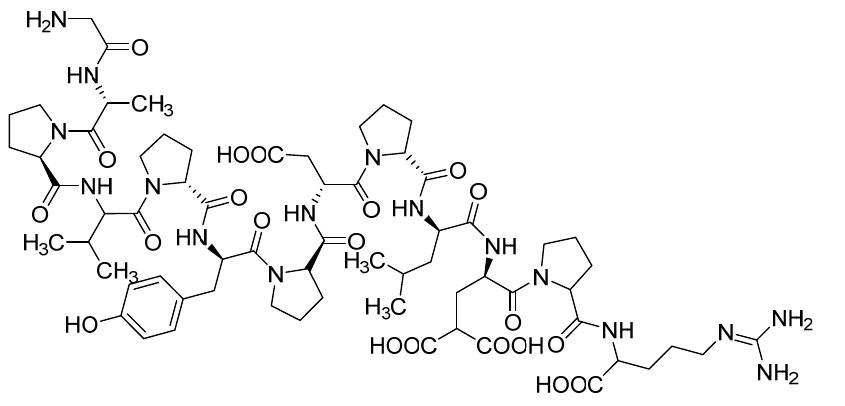
Figure 7. Chemical structure of osteocalcin.